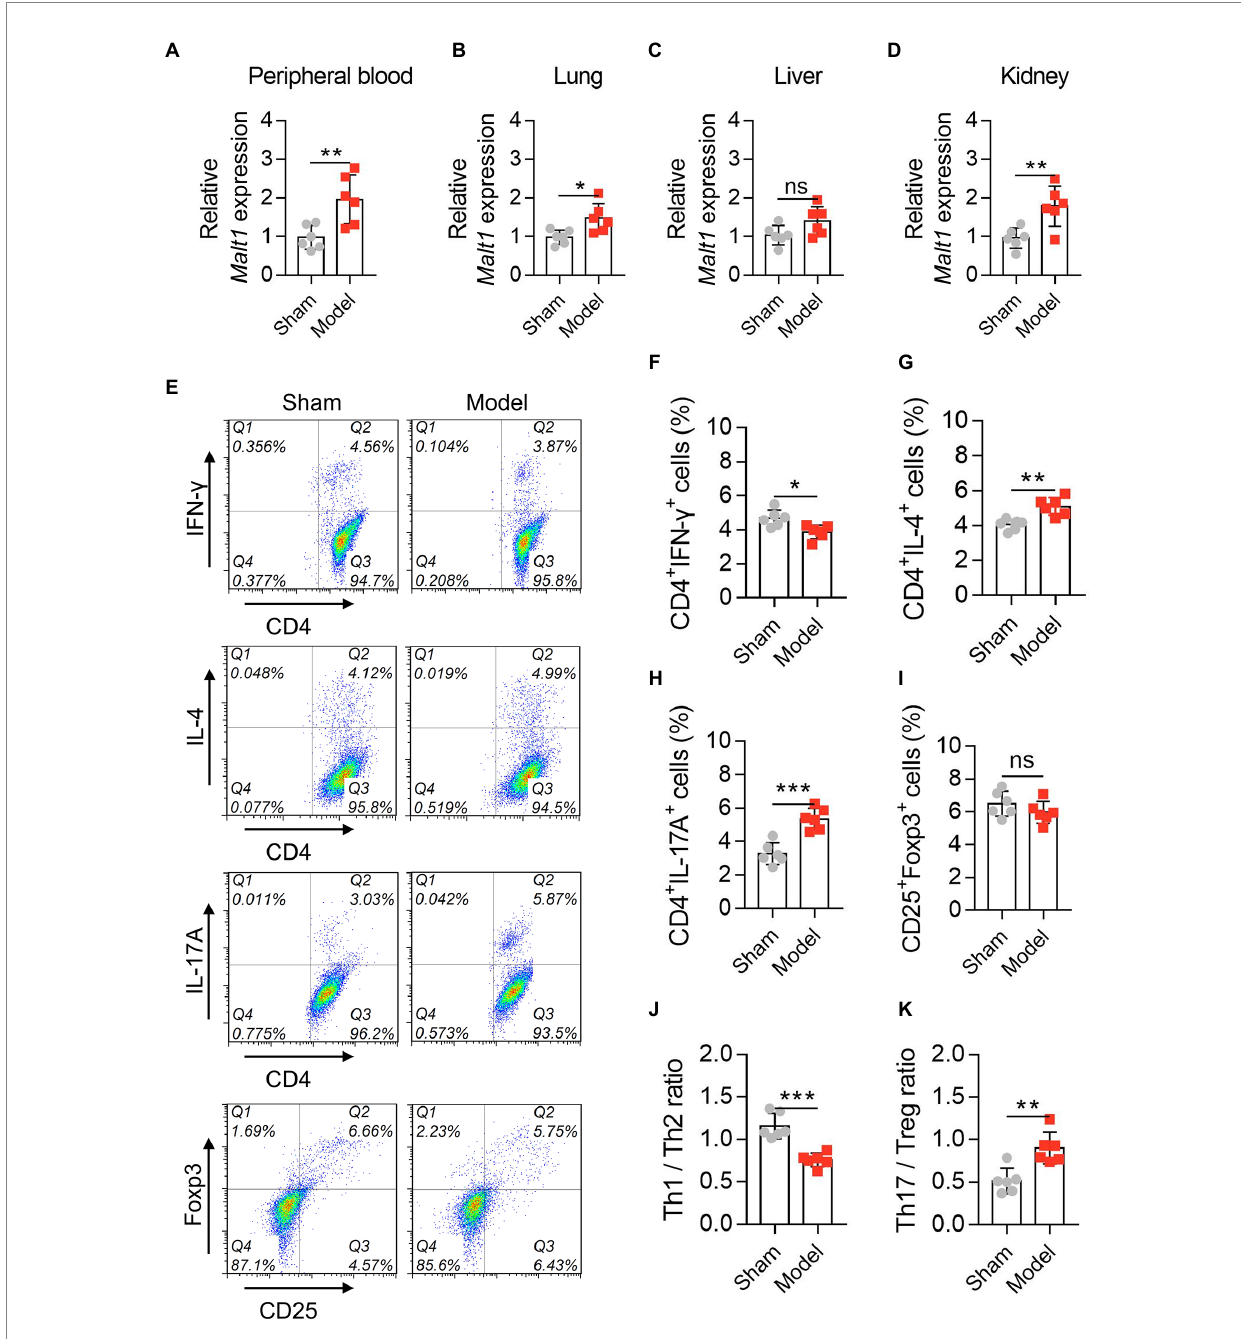
FIGURE 1 MALT1 and CD4 + T cells in LPS-induced septic mouse model. Comparison of Malt1 expression in peripheral blood (A) , lung (B) , liver (C) , and kidney (D) between the Model group and Sham group. Detection of CD4 + T cells by flow cytometry (E) . Comparison of Th1 (F) , Th2 (G) , Th17 (H) , and Treg (I) cells, Th1/Th2 ratio (J) , and Th17/Treg ratio (K) between the Model group and Sham group. n = 6 in each group. Student’s t test was applied. Ns, not significant; * p < 0.05; ** p < 0.01; *** p <